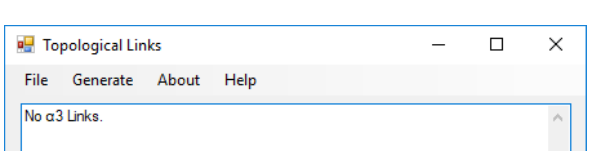
Figure 17. a-3 links result for Dataset